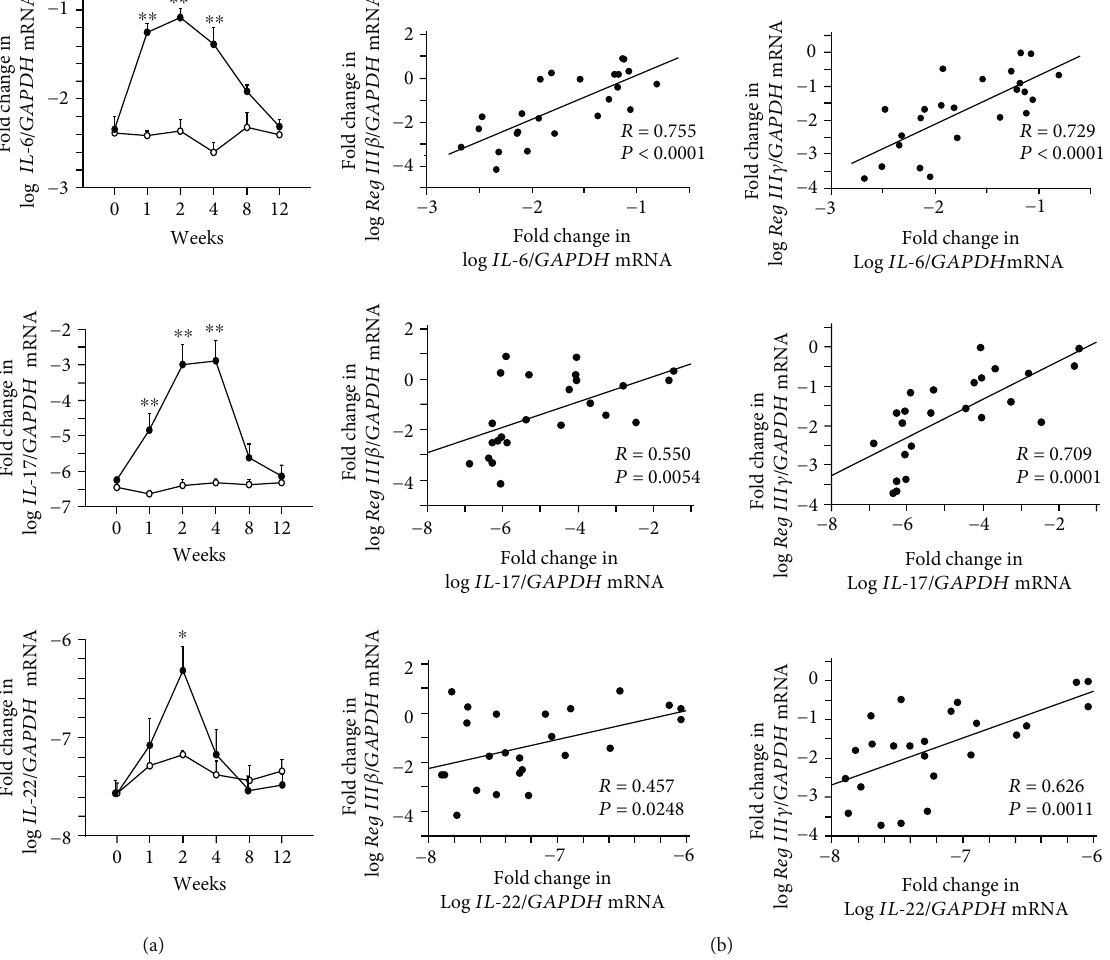
Figure 4: Expression of cytokines and correlation with Reg III β / γ expression in colonic tissue of mice with DSS-induced colitis. (a) Expression of IL-6 , IL-17 , and IL-22 mRNA in colonic tissue of mice with DSS-induced colitis and in controls. (b) Correlation between the expression of mRNA for IL-6 , IL-17 , and IL-22 and that of Reg III β / γ in the colonic tissue. Results are expressed as the mean ± SE . Signi fi cantly greater than in controls at the same time point: ∗ P < 0 : 05 and ∗∗ P < 0 : 01